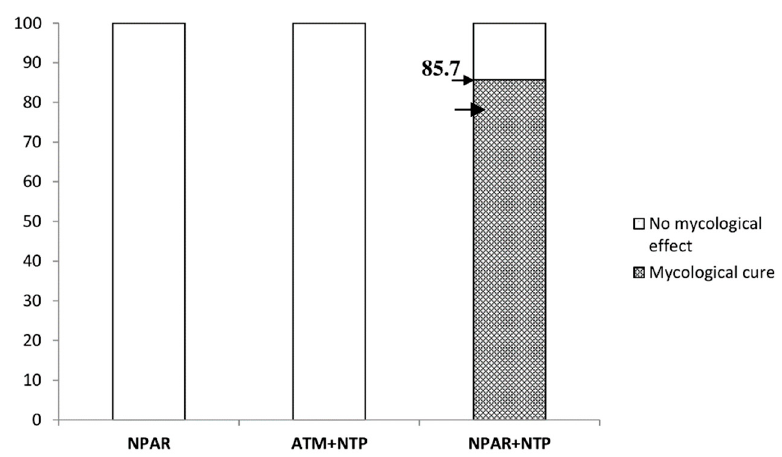
Figure 10. Mycological cure effect (%) in particular groups of patients.